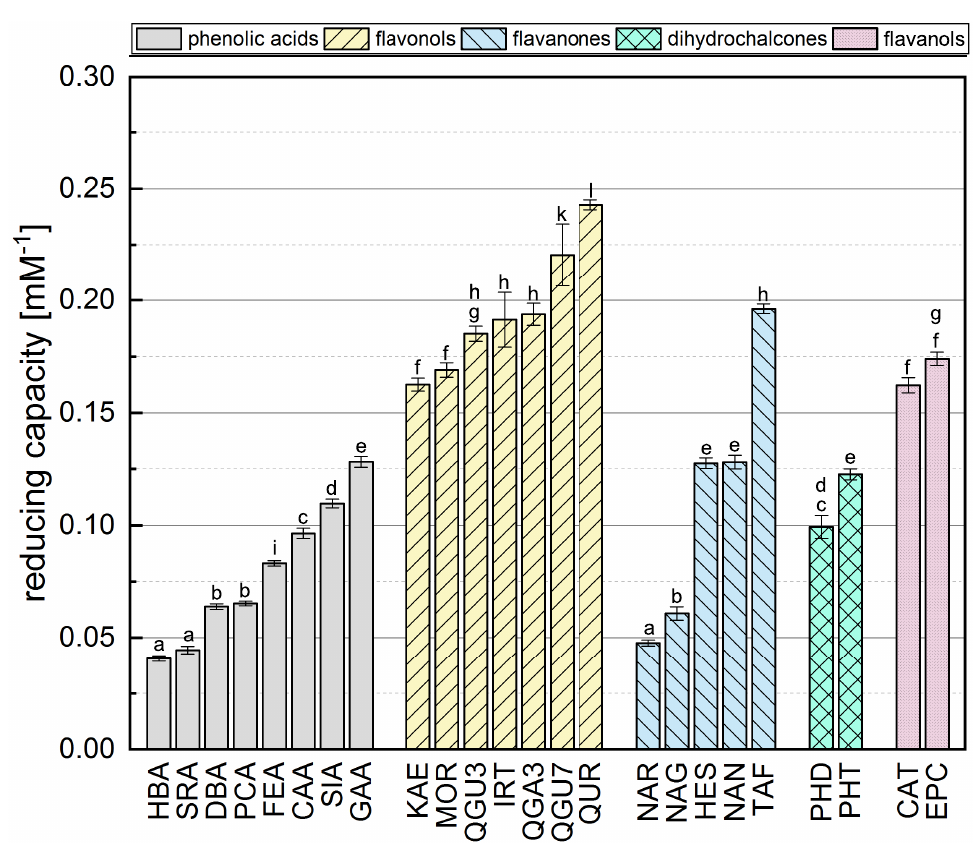
Figure 2. The reducing capacity of all standard reference compounds measured in the FC assay. Equal letters indicate that there is no significant difference between the values. The significance level was